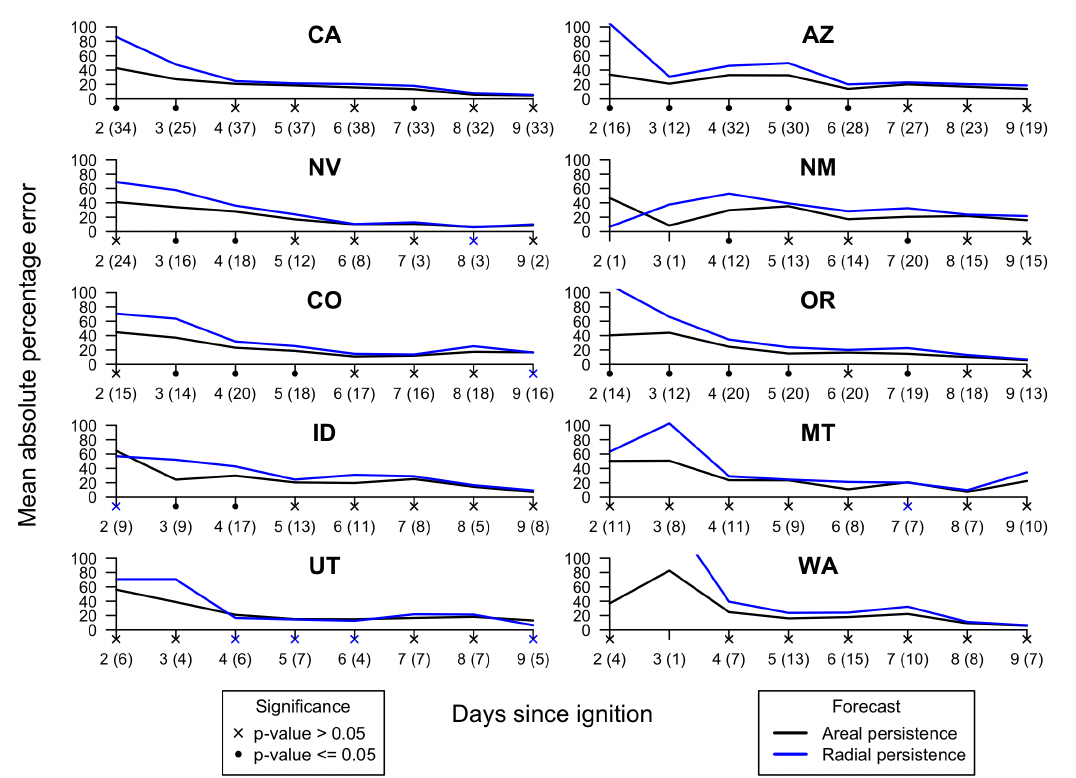
Figure 7. The mean absolute percent error (MAPE) of the areal persistence model and radial persis- tence model as estimated using all available samples from the WoMBATS data. MAPE estimates are stratified by the state and the days since ignition. Below the x-axis, there are points that are black except for days in which the radial persistence model performed better than the areal persistence model, which are instead colored blue. The points are hollow unless the difference in MAPE estimates in the areal persistence model and the radial persistence model are significant, in which case they are solid. Sample sizes are reported in the x-axis in